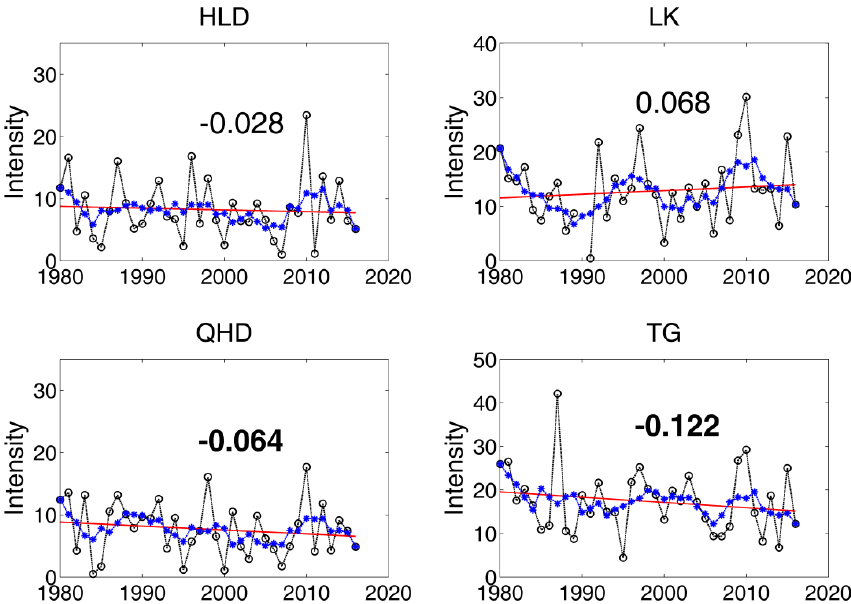
Figure 6. Storm surge intensity (m · h) at HLD, LK, QHD and TG: linear trend (blue line) and five-year running mean (red line). The numbers in the figure are the long-term change rate (m · h/year).